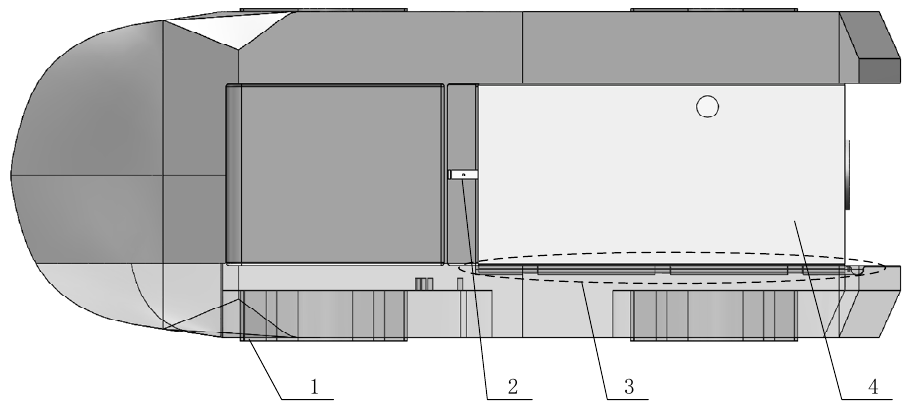
Figure 18. Diagram of test model structure. 1—car body; 2—sensor; 3—slideway; 4—power system. Table 7. Parameters of model test instruments.